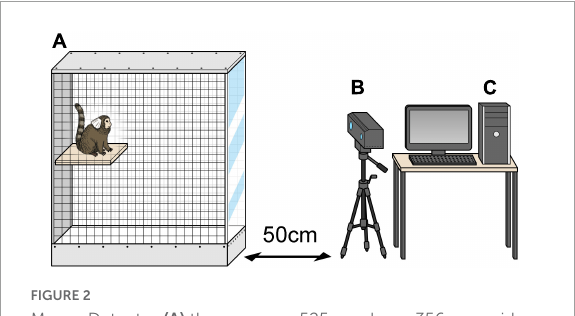
FIGURE1 Schema of the surgical procedure of inducing infarction (A) marmosets were anesthetized with isoflurane and ventilator-controlled. (B) An intravenous catheter was placed in the tail vein and fluids were administered continuously. (C) The marmoset underwent stereotactic craniotomy, and green laser was irradiated on the exposed brain.